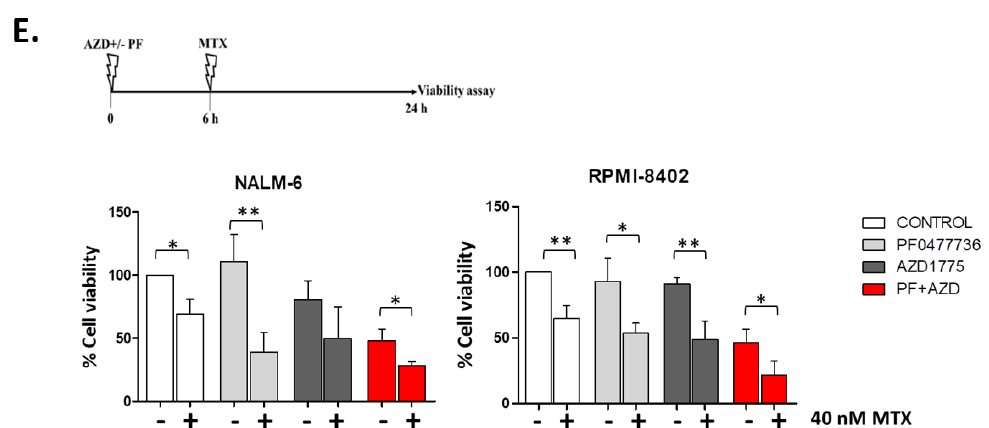
Figure 2. PF-00477736 in combination with AZD-1775 causes early S-phase arrest. ( A ) Cell cycle analyses of NALM-6 cell lines treated simultaneously with subtoxic concentration AZD-1775 (185 nM) and PF-00477736 (250 nM) for 24 h. The histograms show the percentage of cells in a specific cell cycle phase. ( B ) Cell cycle analyses of RPMI-8402 cell lines treated simultaneously with subtoxic concentrations of AZD-1775 (185nM) and PF-00477736 (25 nM) for 24 h. The histograms show the percentage of cells in a specific cell cycle phase. ( C ) Western Blot analyses of RPMI-8402 and NALM-6 cell lines treated for 24 h with AZD-1775 (185 nM) and PF-00477736 (25 and 250 nM respectively). β -actin was used for loading normalization. For relative quantification of each protein see Figure S1C and for whole western blot images see Figure S4. ( D ) The graph represents the normalized RLU (relative light unit) of NALM-6 and RPMI-8402 treated with AZD-1775 (185 nM) and PF-00477736 (25 and 250 nM respectively) for 24 and 48 h. the experiments were performed in triplicates. ( E ) Viability analysis of NALM-6 and RPMI-8402 cell lines treated with AZD-1775 (185 nM) and PF-00477736 (250 and 25 nM, respectively) for 6 h and then with MTX (40 nM) for 18 h. Above the histograms is schematically represented the experimental procedure for the drug combination studies. The flash lighting points when the drugs were added to the cell culture. In the figures statistical significance was represented as asterisks and in detail: p < 0.05 one asterisk (*); p < 0.01 two asterisks (**); p < 0.001 three asterisks (***).